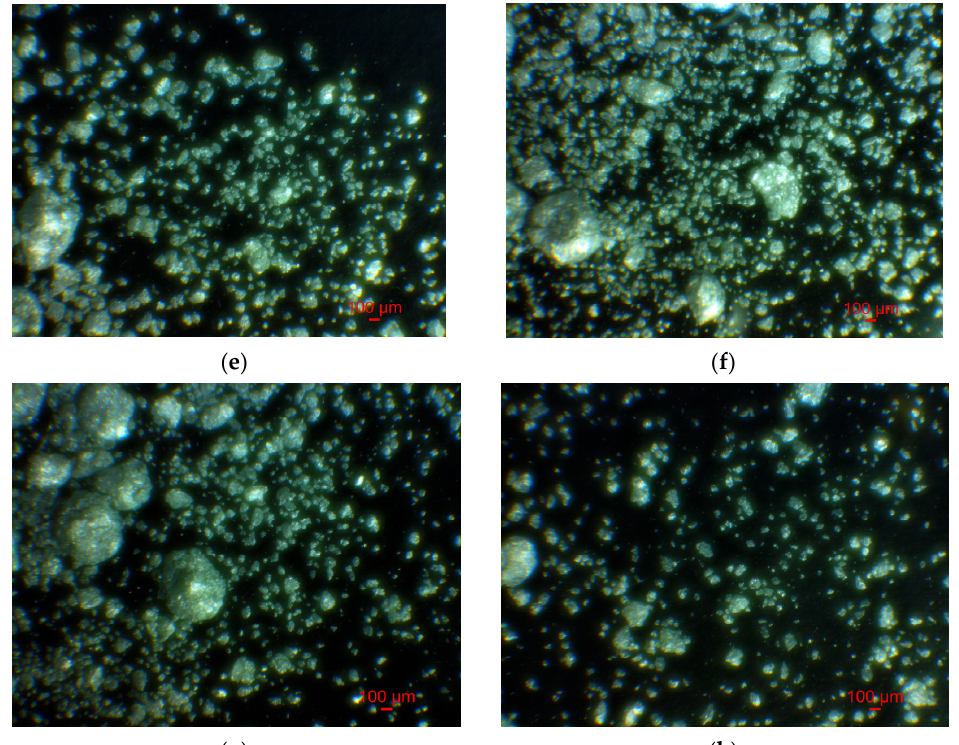
Figure A2. Optical microscope images of scrap and copper composites ball milled at different conditions: ( a ) 50–70 μ m copper powder, 2 h, 5 mm steel balls; ( b ) 50–70 μ m copper powder, 2 h, 10 mm steel balls; ( c ) 50–70 μ m copper powder, 1 h, 10 mm steel balls; ( d ) 50–70 μ m copper powder, 1